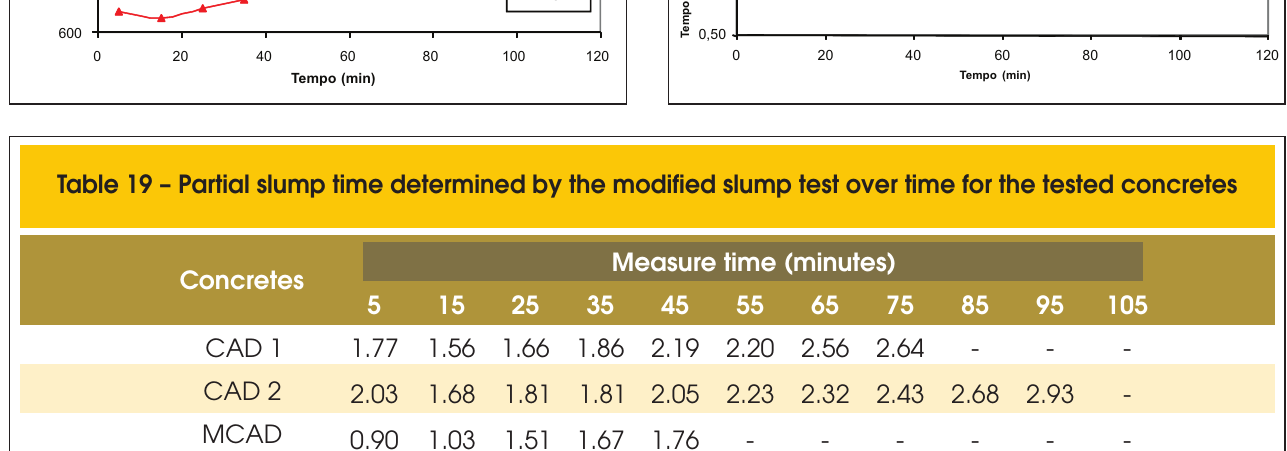
Figure 21 – Evolution of the partial slump time for the tested